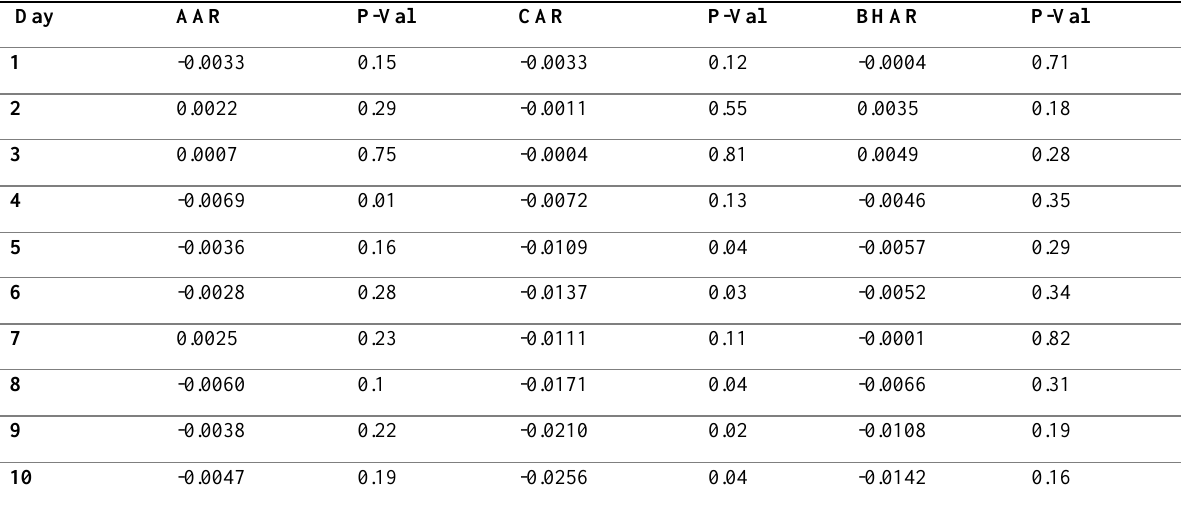
Table 4: The Effect of Positive Earnings Announcement on